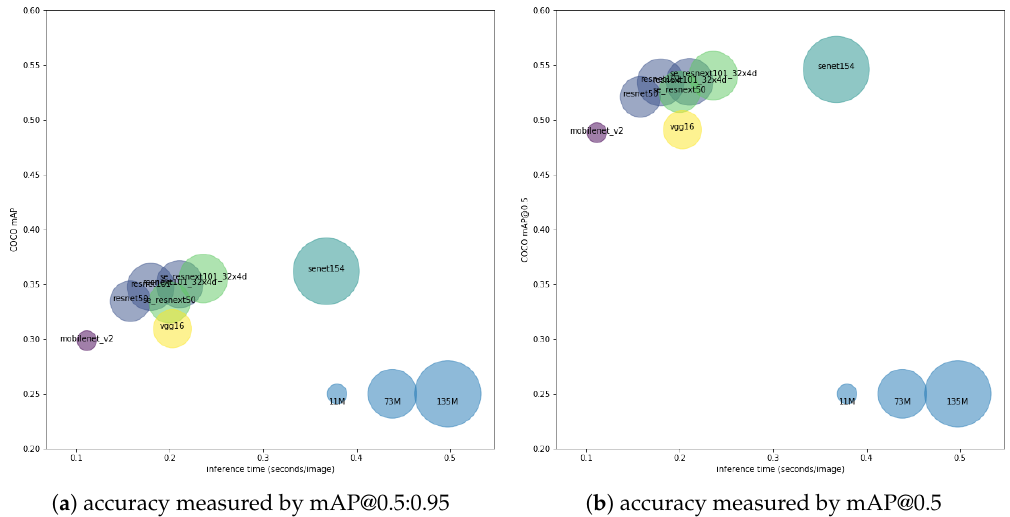
Figure 4. Accuracy vs. memory vs. time, with marker colours indicating backbone net and size indicating number of parameters. The accuracy metrics are different in ( a ) and ( b ): mean average precision over different IoU threshold from 0.5 to 0.95 is used in ( a ), and mean average precision with IoU threshold at 0.5 is used in ( b